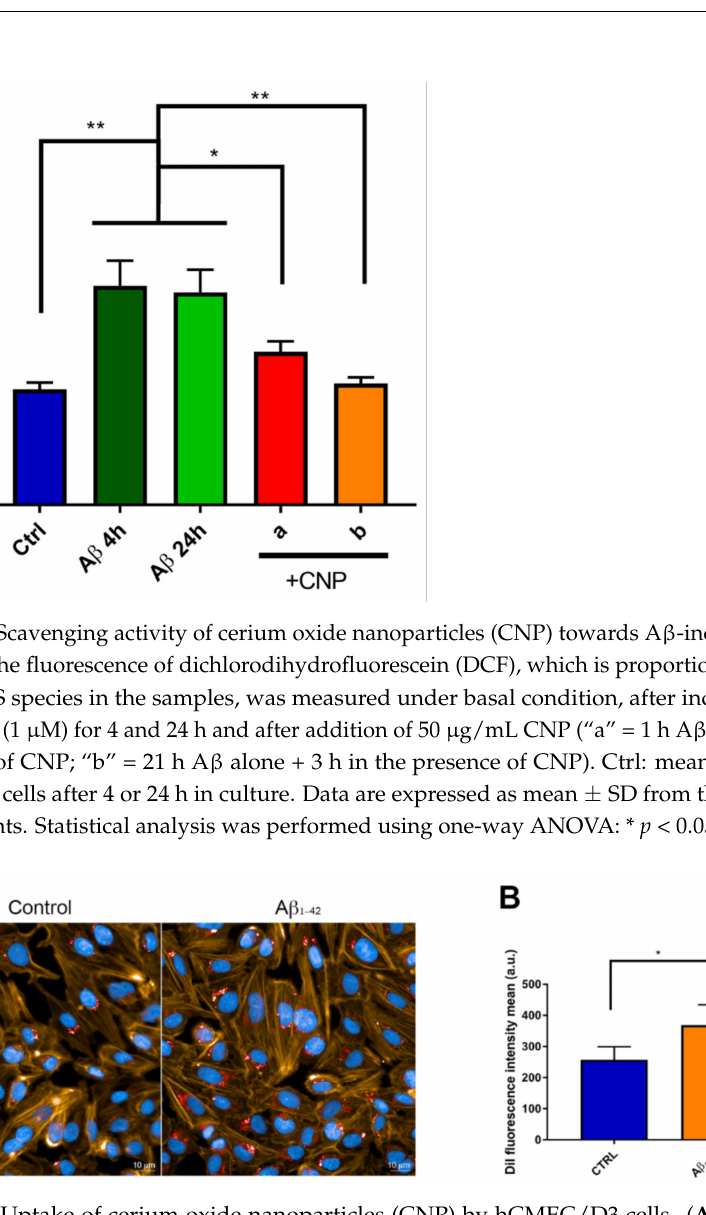
Figure 4. Uptake of cerium oxide nanoparticles (CNP) by hCMEC/D3 cells. ( A ) Fluorescent mi- croscopy images show the internalization of CNP (50 µ g/mL, 3 h of incubation) by hCMEC/D3 cells under basal conditions (left panel) and after 1 h of exposure to 1 µ M A β 1-42 oligomers (right panel). Red staining is DiI-labeled CNP, orange staining is phalloidin-labeled cytoskeleton and blue is nuclear staining. ( B ) Quantification of CNP-associated fluorescence in the two experimental conditions. About 400 cells were analyzed per group. Data are expressed as mean ± SD from three independent experiments. Statistical analysis was performed using a Student’s t -test: * p < 0.05. These same observations were also confirmed by SEM analysis (Supplementary